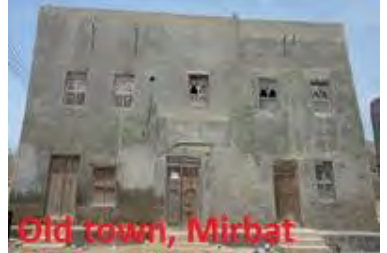
Figure 9. Fac¸ade’s photograph building location